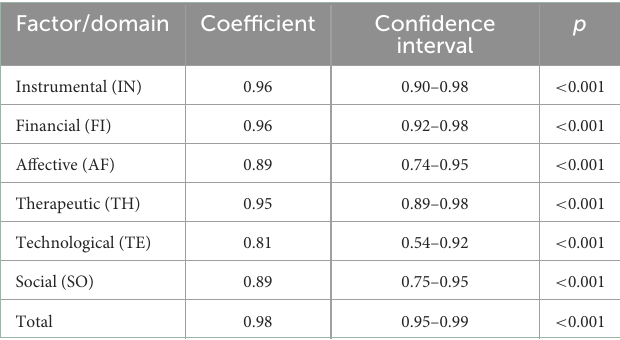
FIGURE7 Confirmatory factor analysis model of the social dimension of the family support for older people questionnaire. All items in the questionnaire showed a factor load > 0.3, indicating appropriate metrics for the tool factor. TABLE 4 The intraclass correlation coefficient (ICC) of the domains and the whole